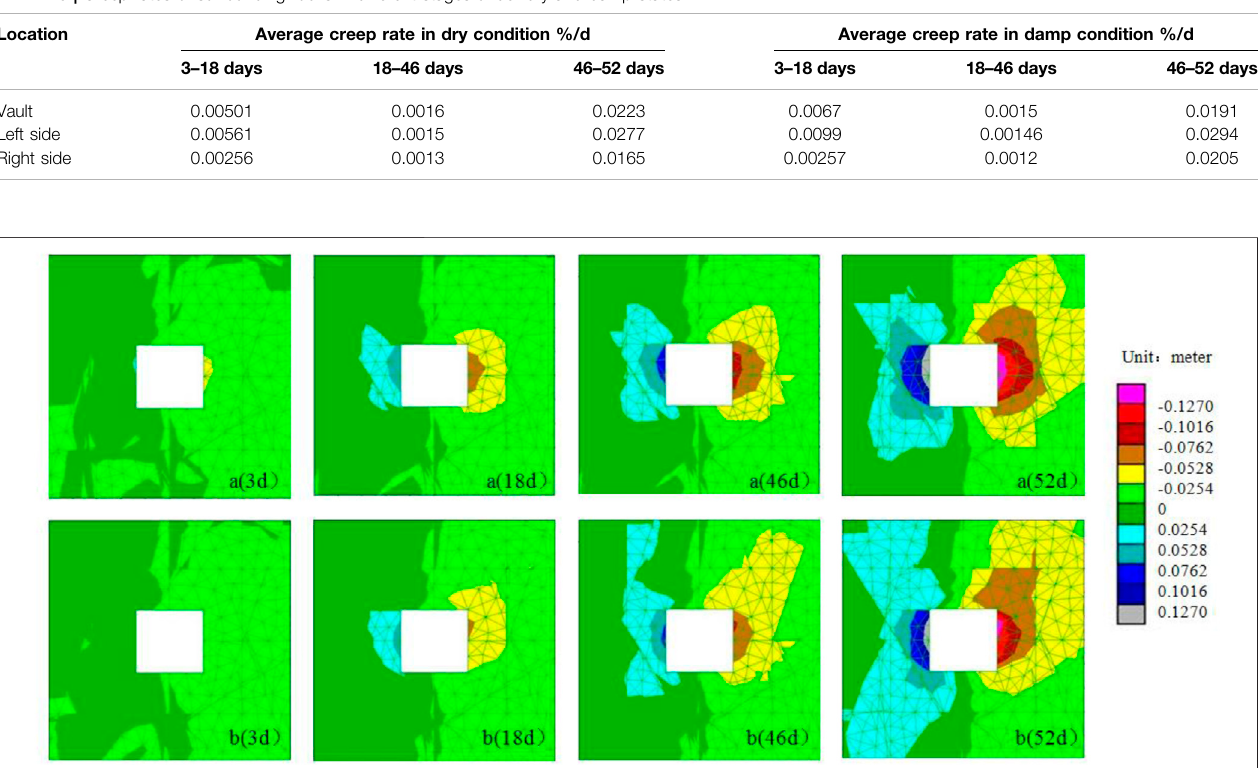
Frontiers in Earth Science |